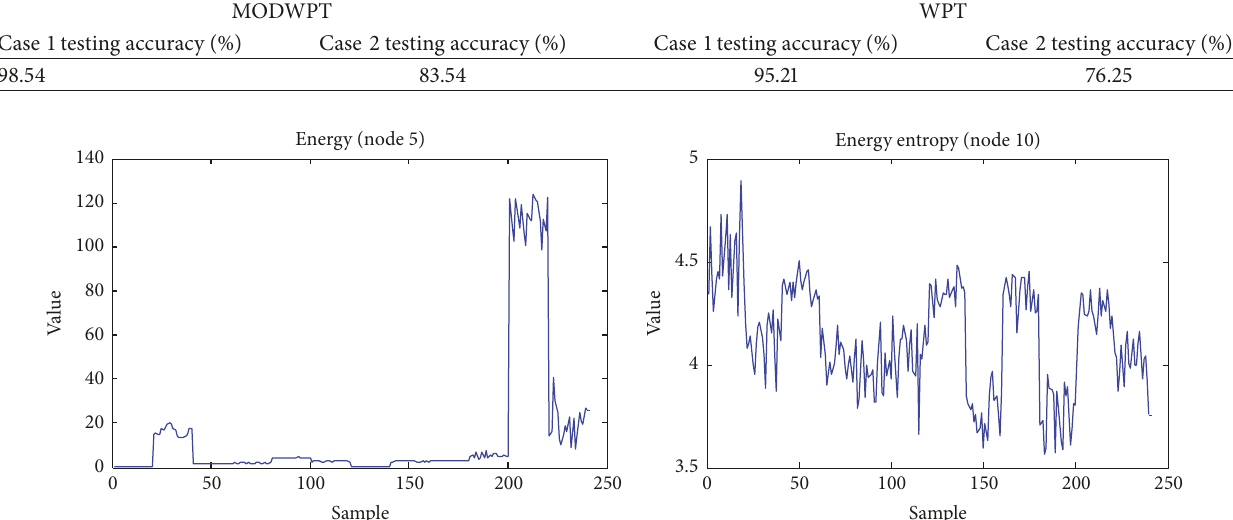
Figure 5: Two time-domain statistical characteristics of the training samples.